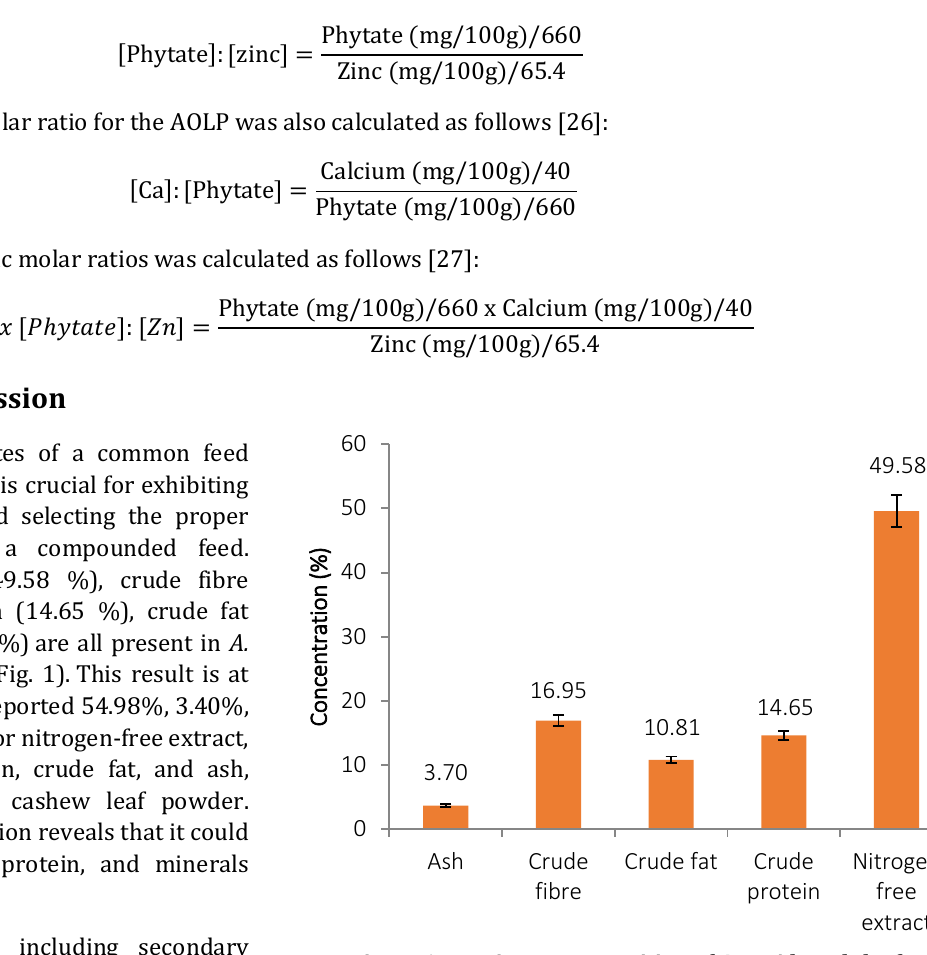
Figure 1. Proximate composition of A. occidentale